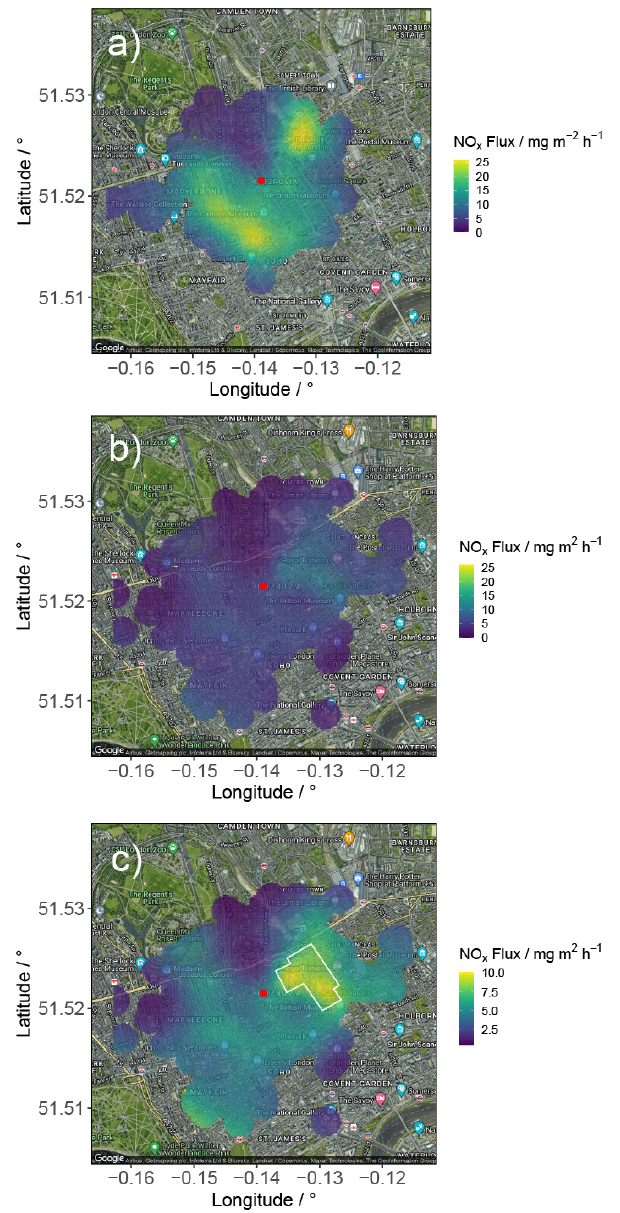
Figure 6. NO x flux surfaces as a function of along-wind distance to the footprint maximum contribution and wind direction, as derived by Drysdale et al. (2022), for (a) March through August 2017 and (b) September 2020 to September 2021, displayed on the same scale for ease of visual comparison. Also shown in (c) : September 2020 to September 2021 on its own scale with the border for the University of London overlaid in white. The location of the BT Tower site is displayed as a red dot in each spatial map. Maps are produced using Google Maps (© Google Maps 2022), accessed using an API in